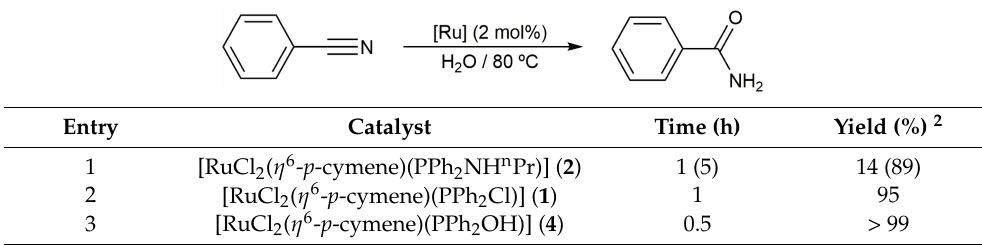
Table 1. Hydration of benzonitrile into benzamide catalyzed by complexes 1 , 2 and 4 in water 1